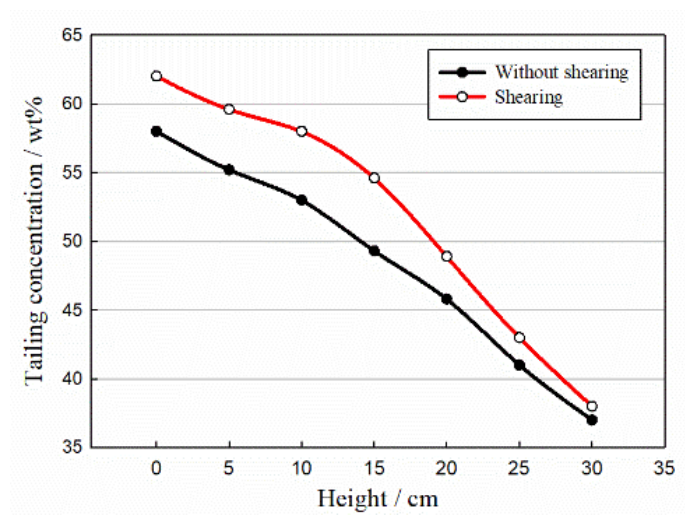
Figure 4. The concentration distribution of the tailings in the bed.